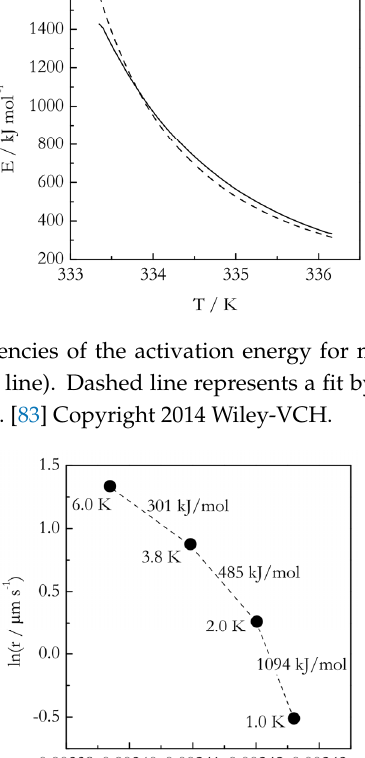
Figure 5. Temperature dependencies of the activation energy for melting of poly( ε‐ caprolactone) estimated experimentally (solid line). Dashed line represents a fit by Equation (26). Adapted with permission from Vyazovkin et al. [83] Copyright 2014 Wiley ‐ VCH.